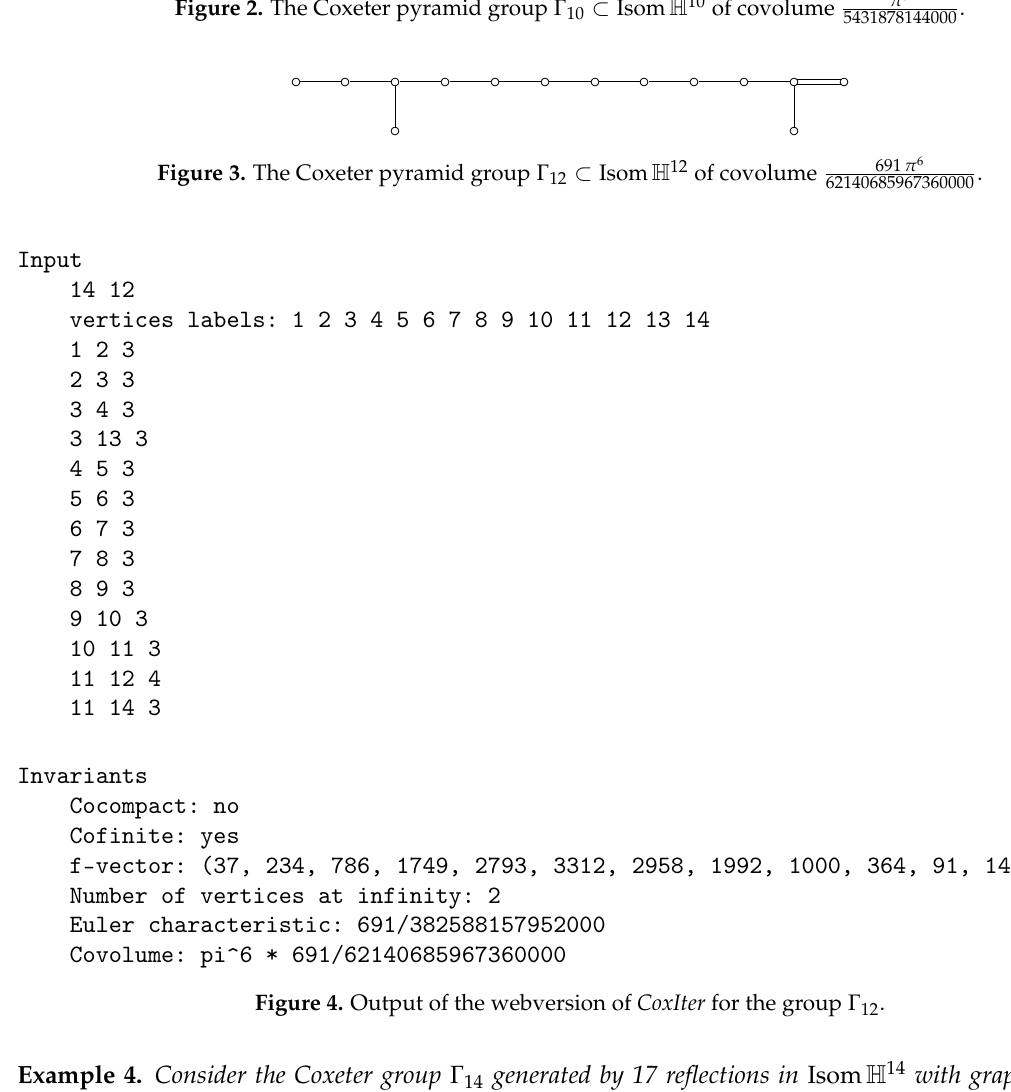
Figure 2. The Coxeter pyramid group Γ 10 ⊂ Isom H 10 of covolume π 5